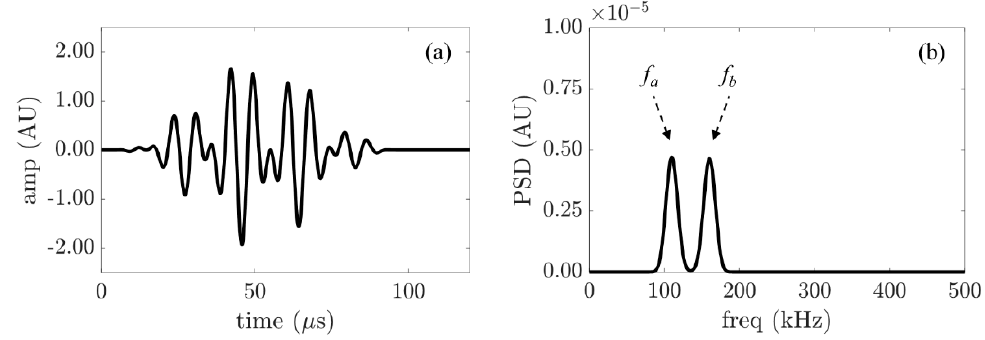
Figure 5. ( a ) Typical time history of the input signal created by merging two signals at different frequencies; ( b ) Typical spectrum of the input signal.